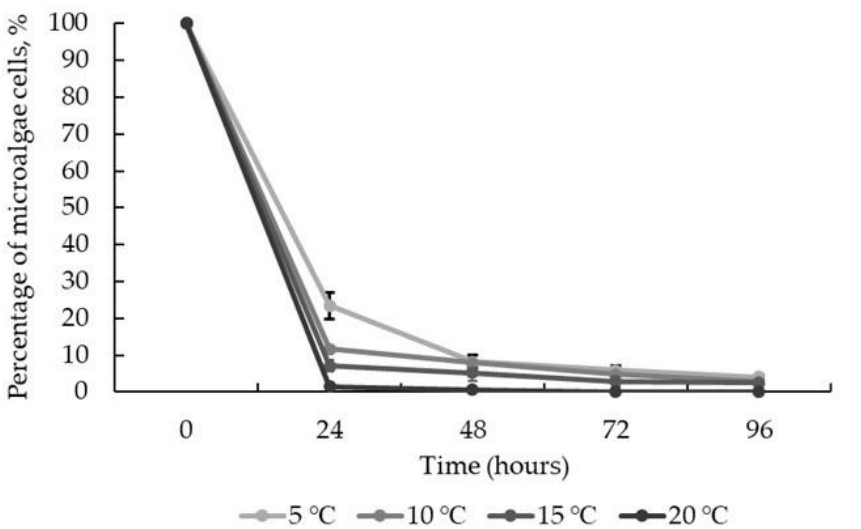
Figure 6. T. obliquus harvesting efficiency at 5, 10, 15 and 20 °C with I. lacteus pellets. Standard deviation represents the average from three replicates.